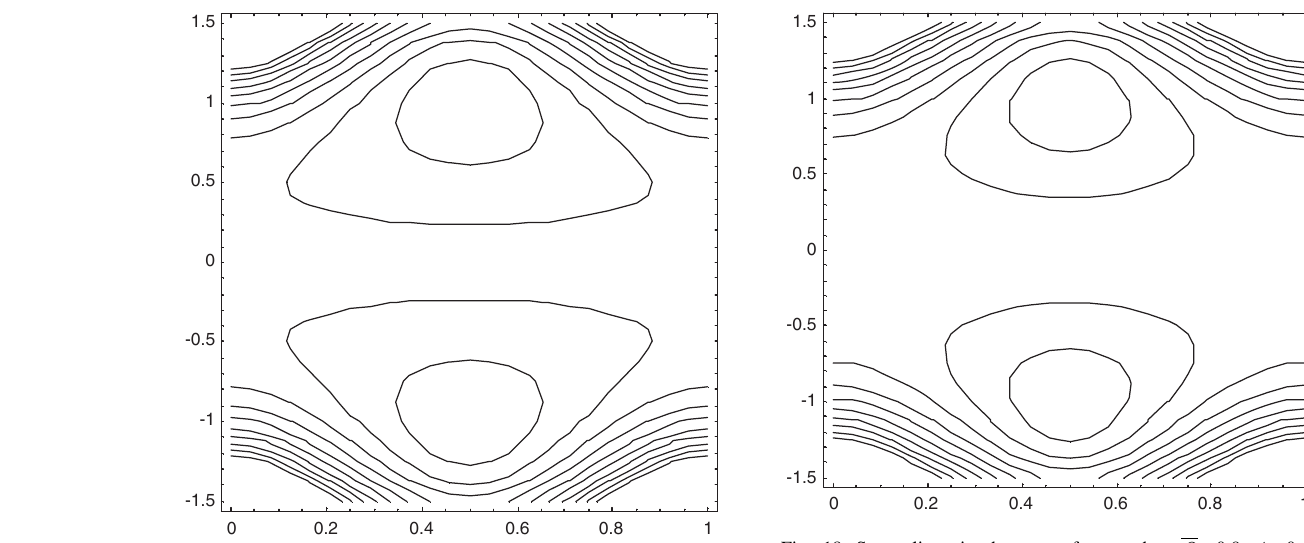
Fig. 16. Streamlines in the wave frame when Q =0.9, φ =0.6, M =0.1, N =0.25.